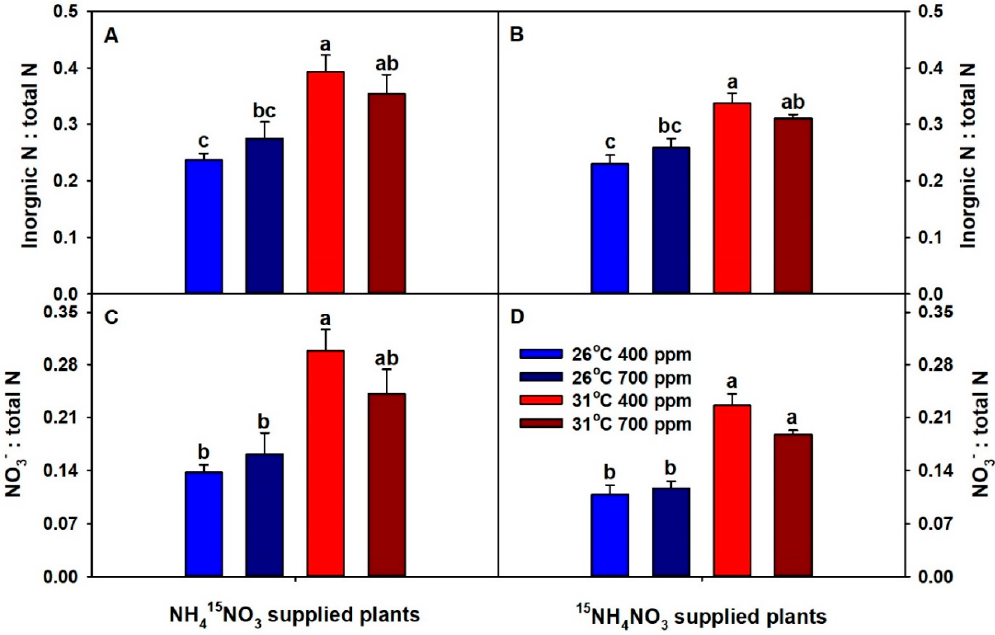
Figure 3. The effects of ambient (400 ppm) vs. elevated (700 ppm) CO 2 and near-optimal (26 °C) vs. chronic warming (31 °C) daytime temperatures on total-plant ( A,B ) inorganic N:total N and ( C,D ) NO 3 − : total N ratios of either NH 415 NO 3 or 15 NH 4 NO 3 supplied Triticum aestivum cv. Glenn plants grown for 21 or 23 days, respectively. Each bar represents mean ( n = 4 or 5) + 1 SEM. Within each panel, bars not sharing the same letters are significantly different ( p < 0.05, Tukey's test). The whole-plant total-protein concentration was significantly reduced only by CO 2 (Table S1, Figure 4).